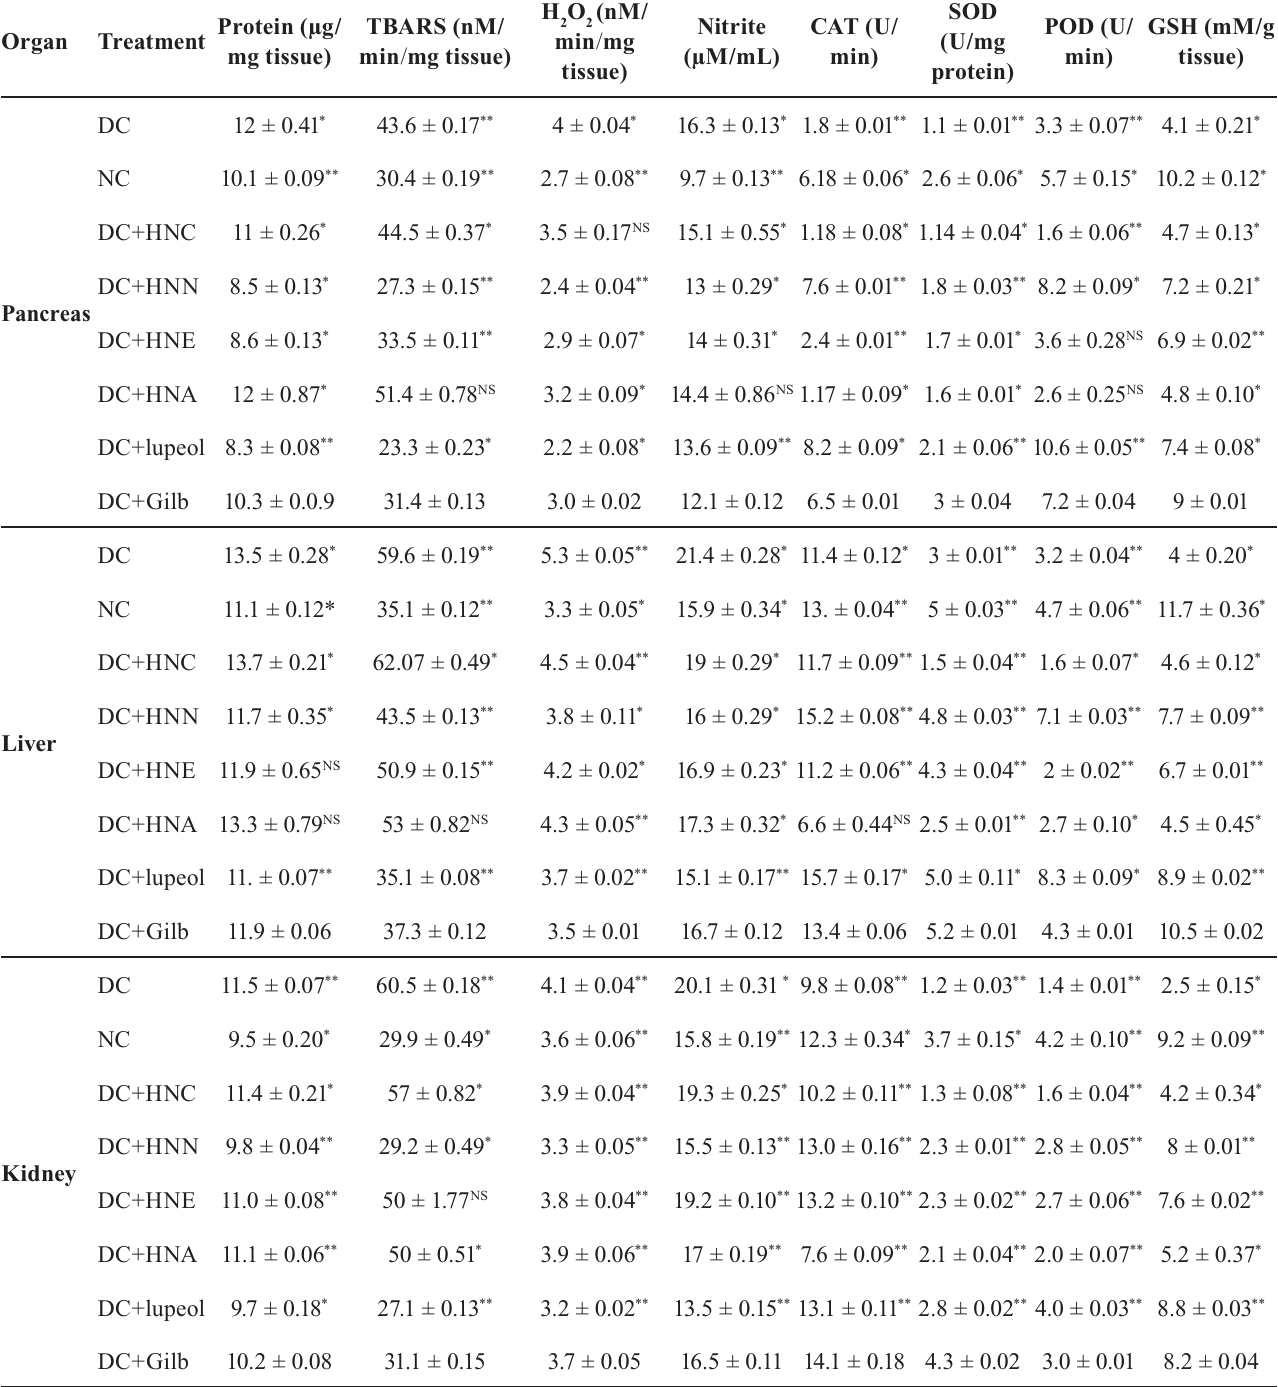
TABLE III - Effects of H. nepalensis extracts and lupeol on pancreas, liver, kidney and heart biomarkers in alloxan induced diabetic